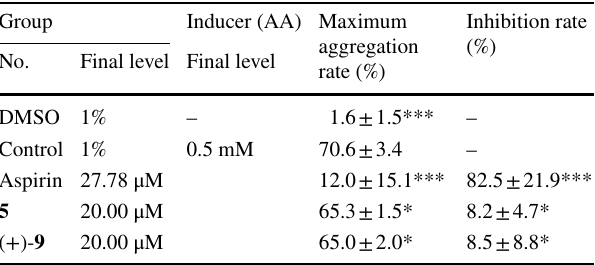
* P < 0.05 versus Table 8 Inhibitory effects of the isolates on AA induced platelet X aggregation in rabbits ( ± SD, n = 3)